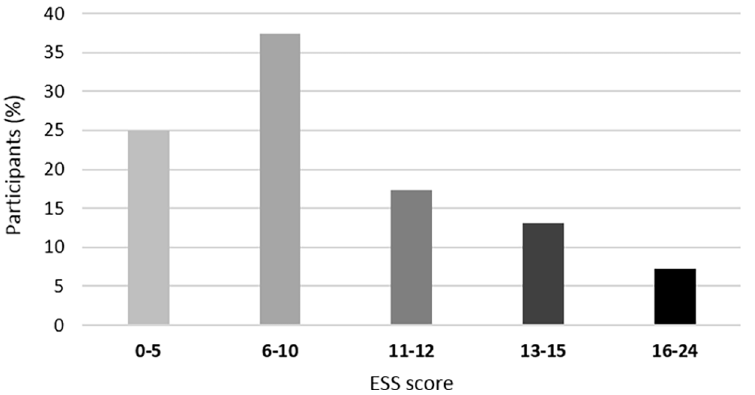
Fig 3. Percentage of participants with each ESS score range.